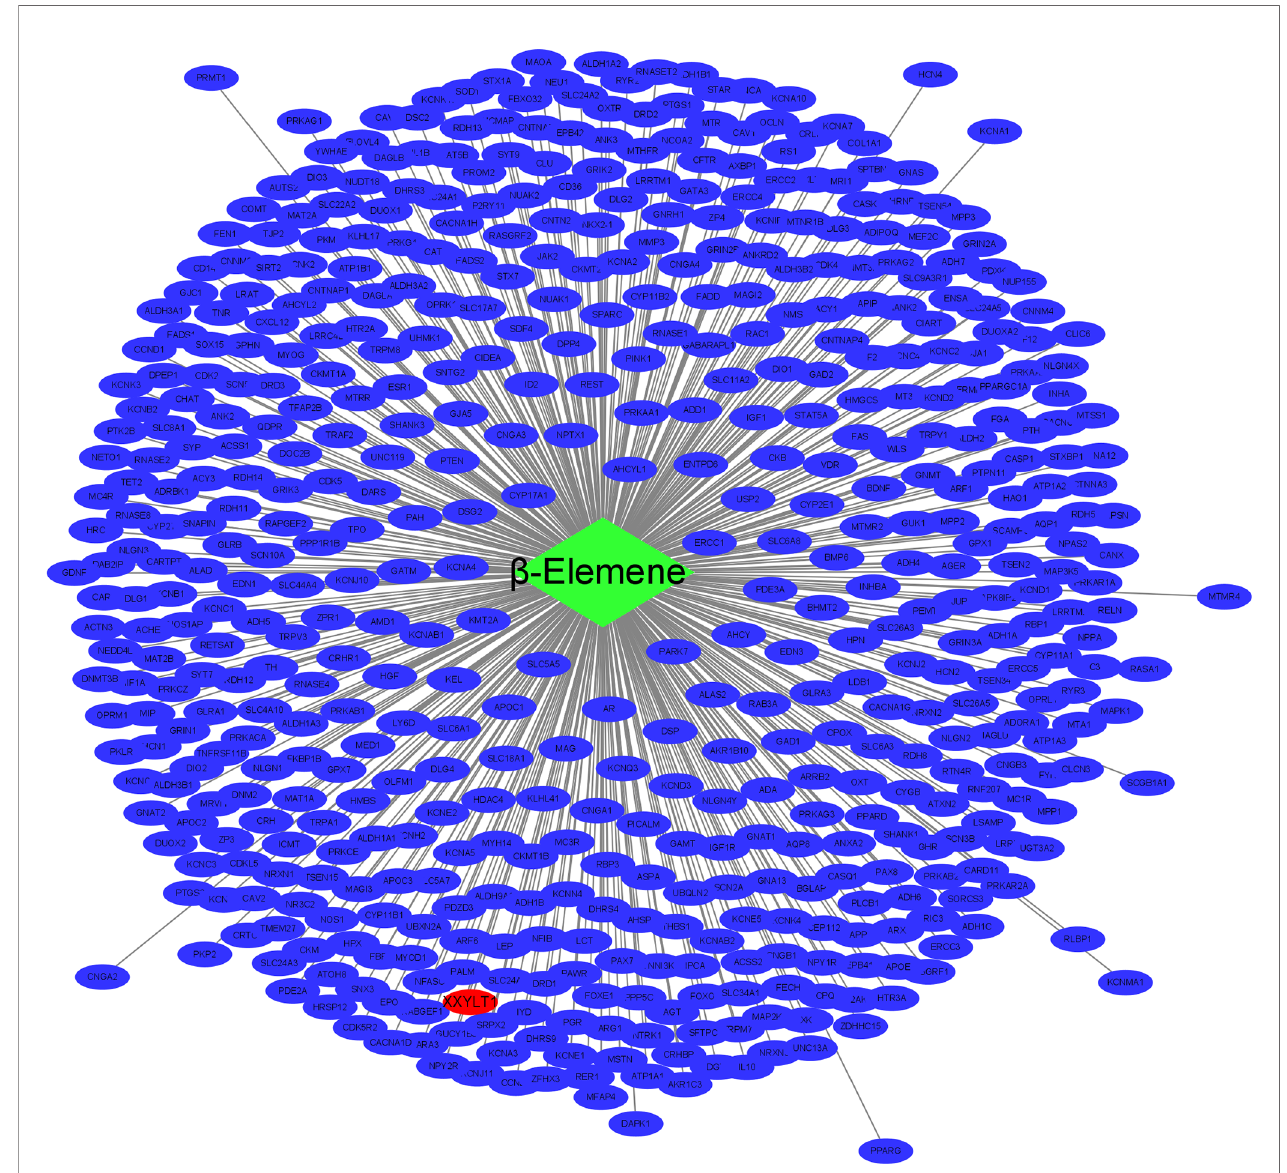
FIGURE 2 | The network of beta-elemene with the potential targeted genes. green rhombus represents beta-elemene; blue ellipse represent the targeted genes of beta-elemene; red ellipse represent the